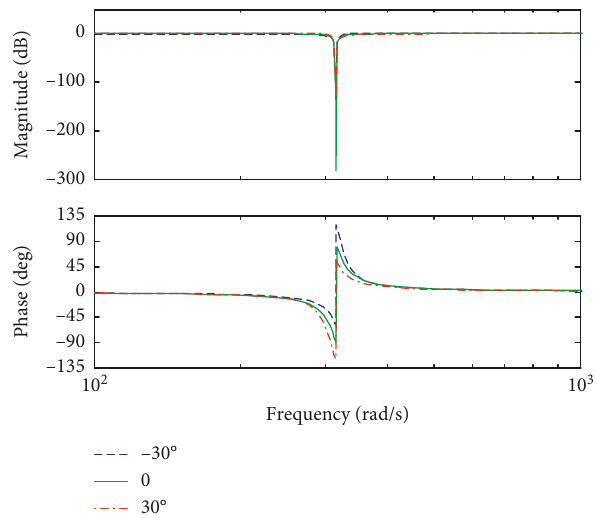
Figure 6: The frequency response of E ( s ) in